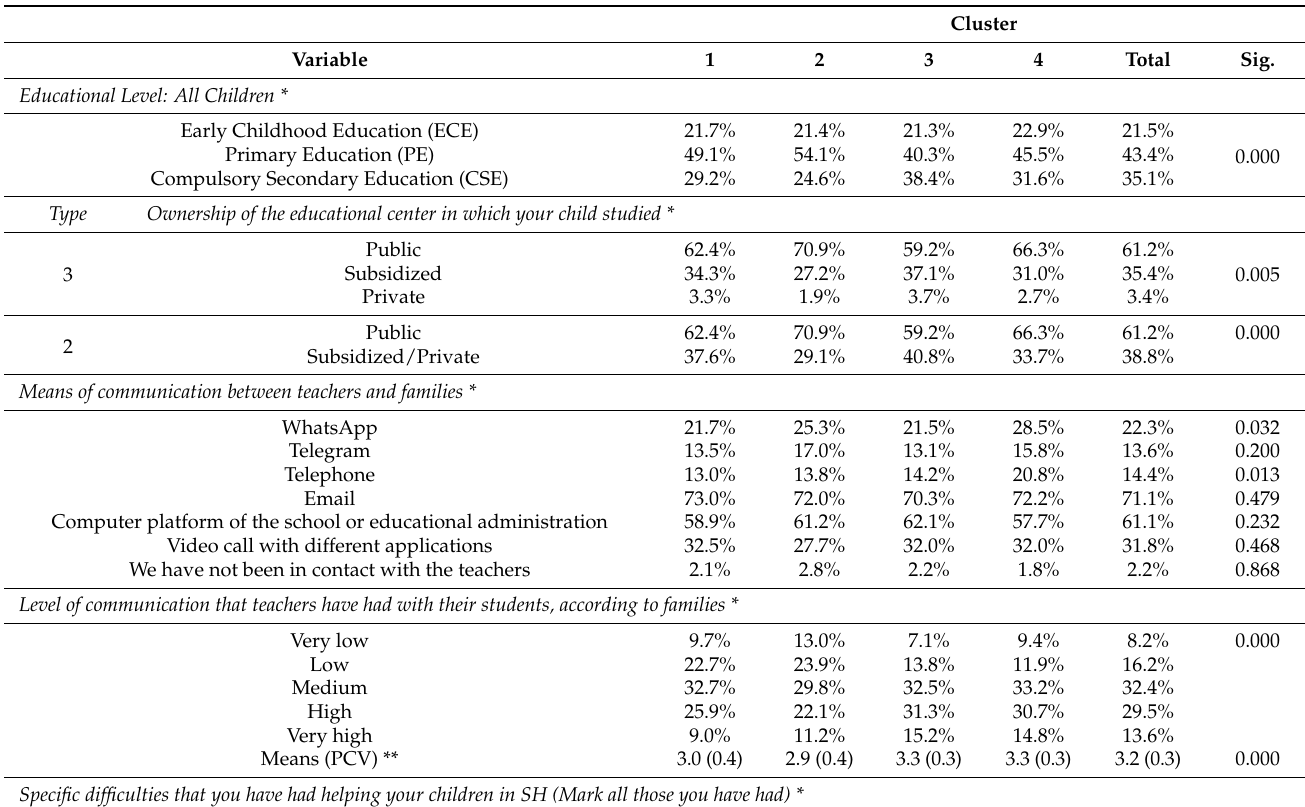
Table 7. Families’ perceptions of the SH functioning in the VC and its association with clusters (Base: Number of children). Variable 1 Total